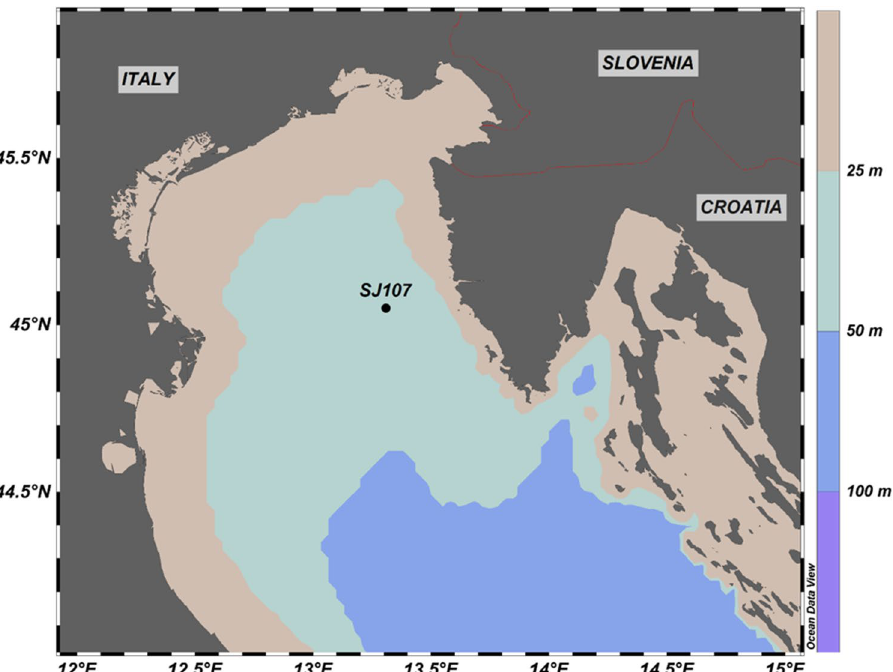
Figure 1. Sampling area: station (SJ107) where vertical net hauls for isolation of the species were performed is